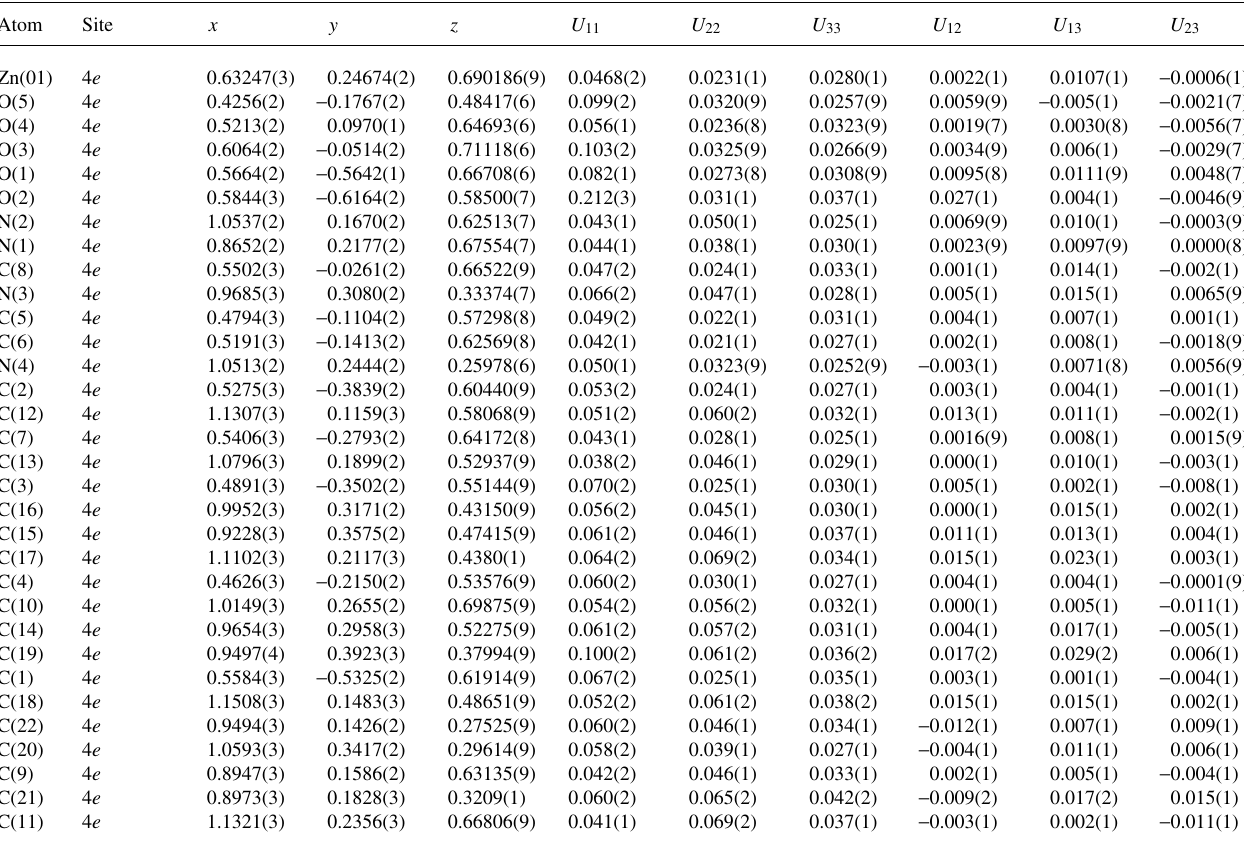
Table 3. Atomic coordinates and displacement parameters (in Å 2 )